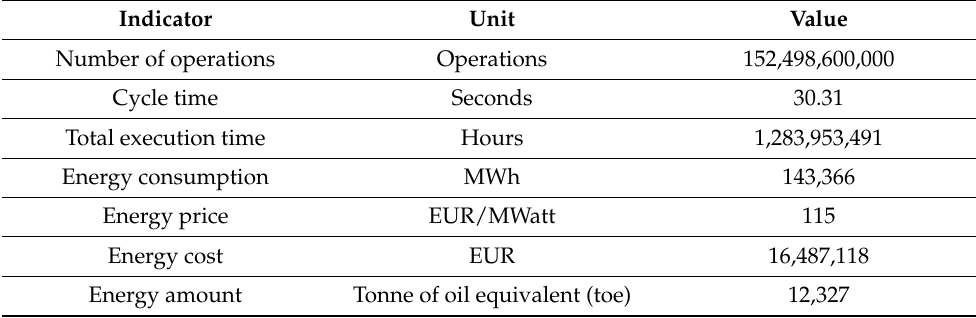
Table 8. The maintenance cost of a POS terminal to complete a payment